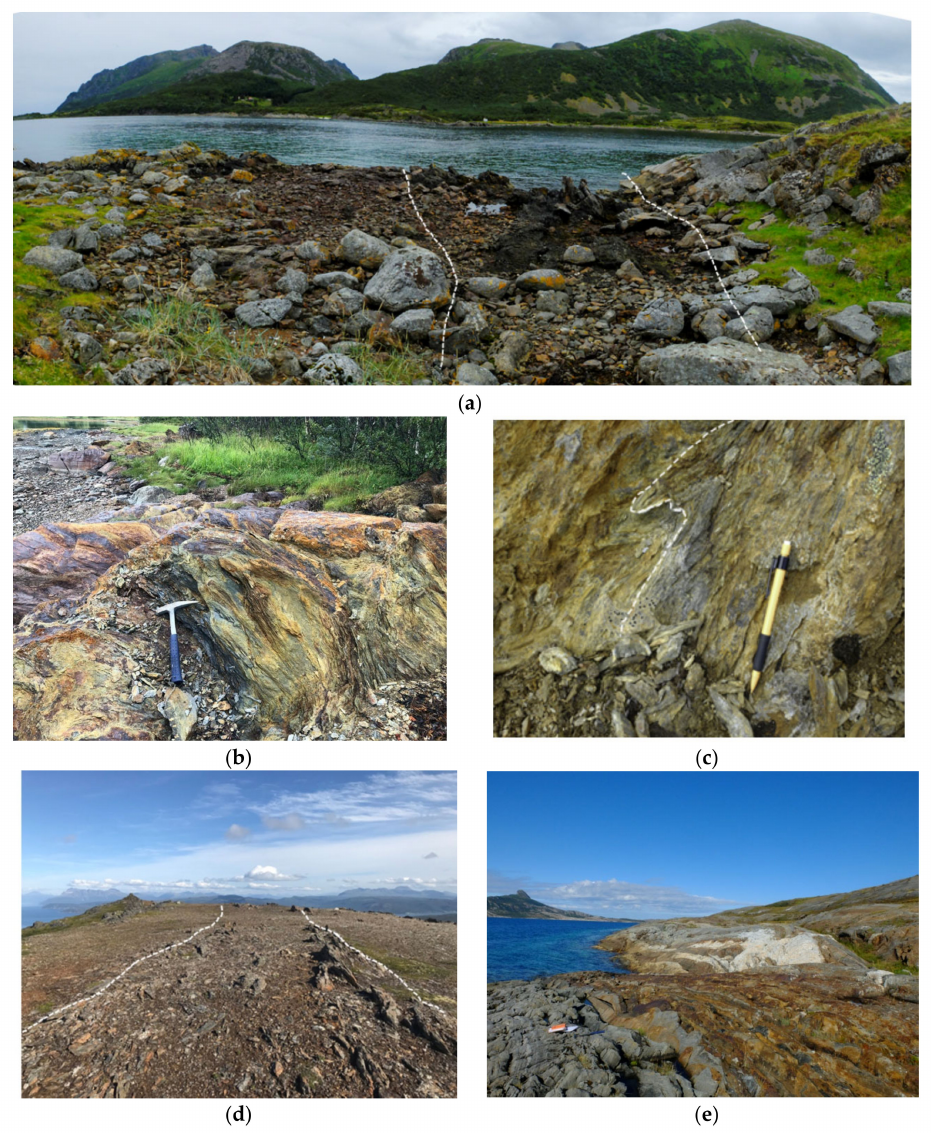
Figure3. ( a )Well-exposedmassivegraphiteschist(Svinøya, occurrence24). ( b )Typicalrusty, weathered, and strongly schistose graphite schist (Grunnvåg, occurrence 6). ( c ) Close-up of typically foliated and tightly folded graphite schist, foliation indicated (Vardfjellet, occurrence 2). ( d ) Outcropping graphite schist continuing about 100 m along strike (Bukken, occurrence 4). ( e ) Outcrop showing from left to right a gradual transition from amphibolitic schist into rusty graphite schist that are intruded by younger granites to the right (Nord-Værnes, occurrence